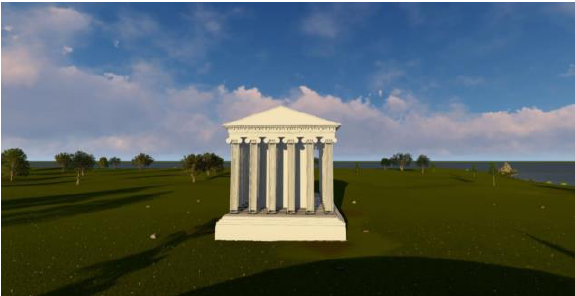
Figure 13. Reconstruction of the Temple of Dionysos at Teos